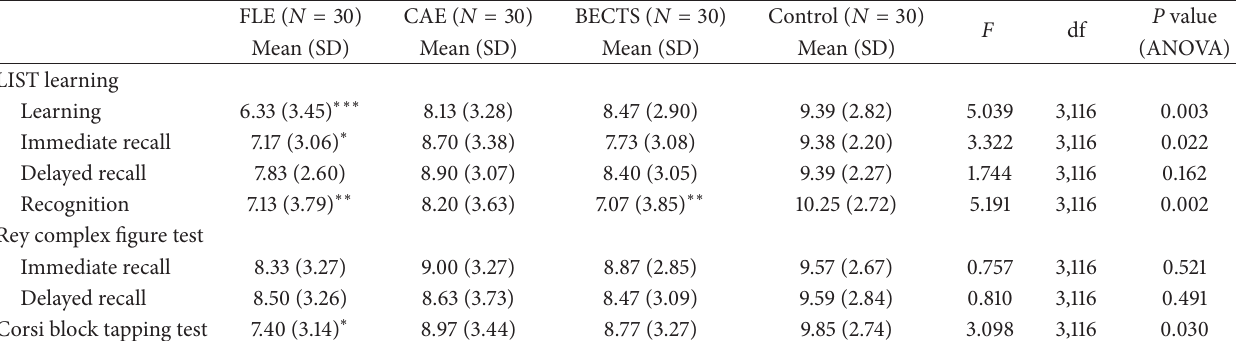
Table 2: Memory tests